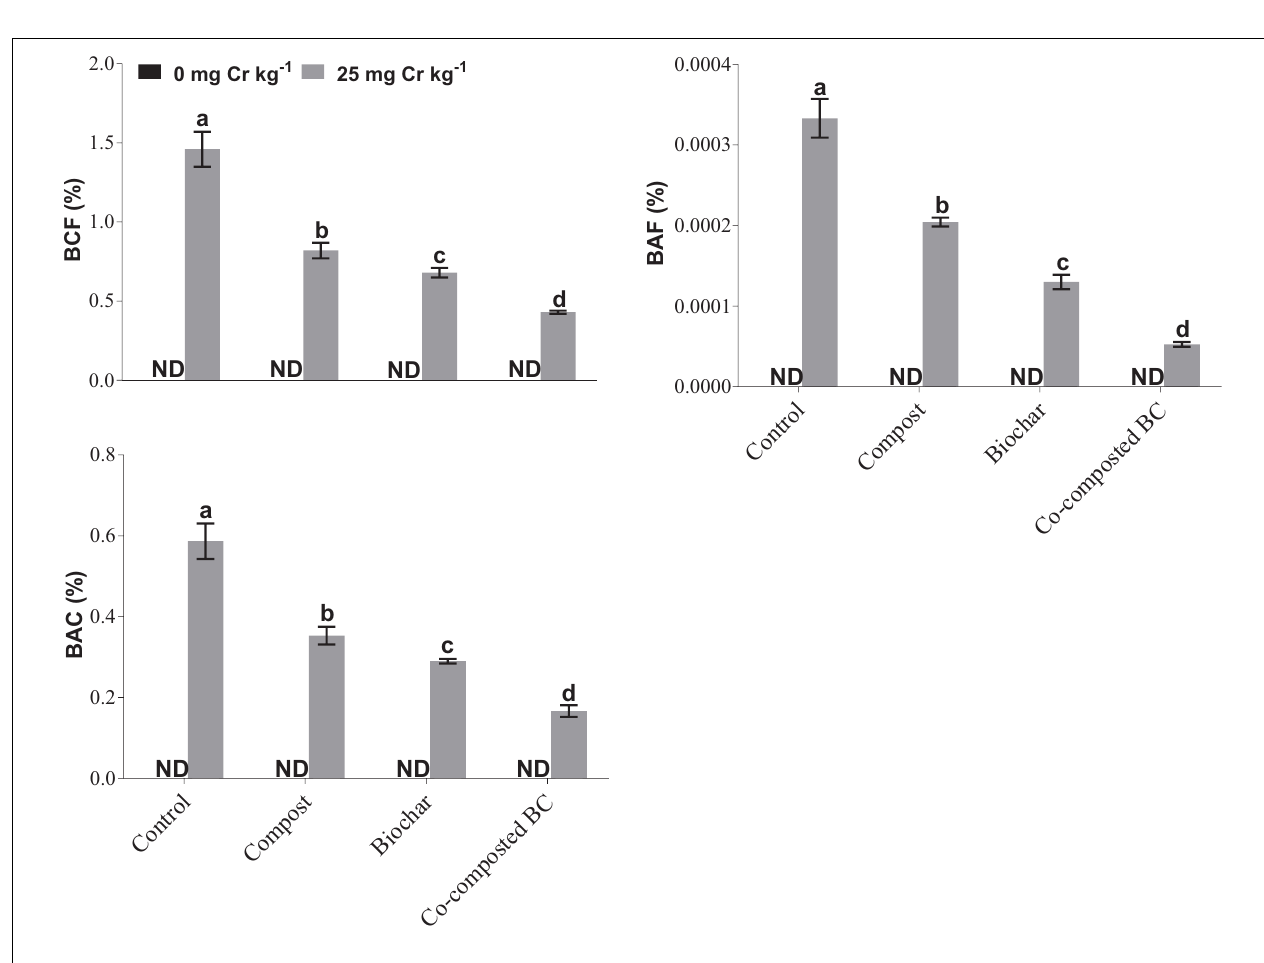
FIGURE 7 | Impact of compost, biochar, and co-composted biochar on bioconcentration factor (BCF), bioaccumulation factor (BAF), and bioaccumulation concentration (BAC) of Brassica napus . The values are presented as mean ± standard error ( n = 3). The values sharing the same letter(s) in bars are statistically non-significant with each other at p <